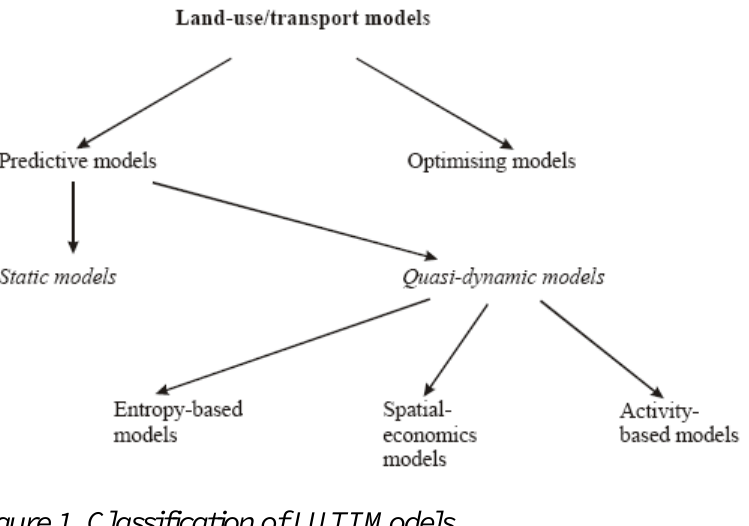
Figure 1. Classification of LUTI